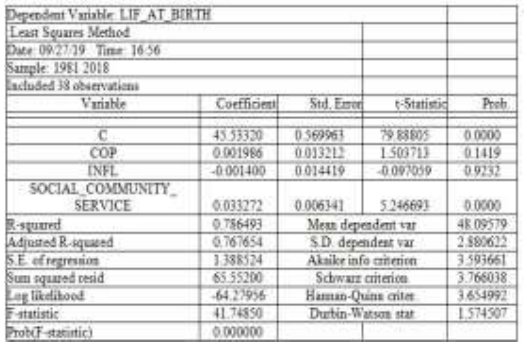
Table 3: Model 1 (Least Square Method of Analysis)